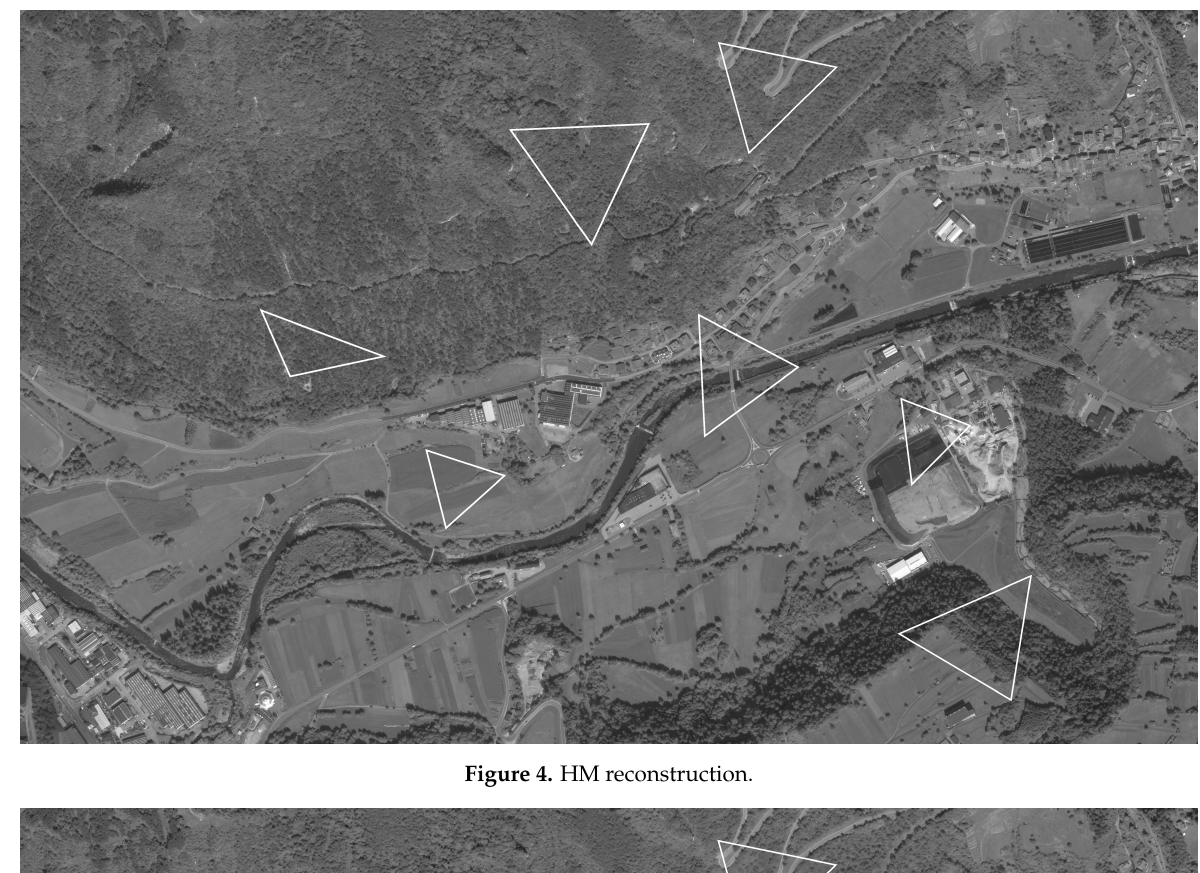
Figure 4. HM reconstruction.